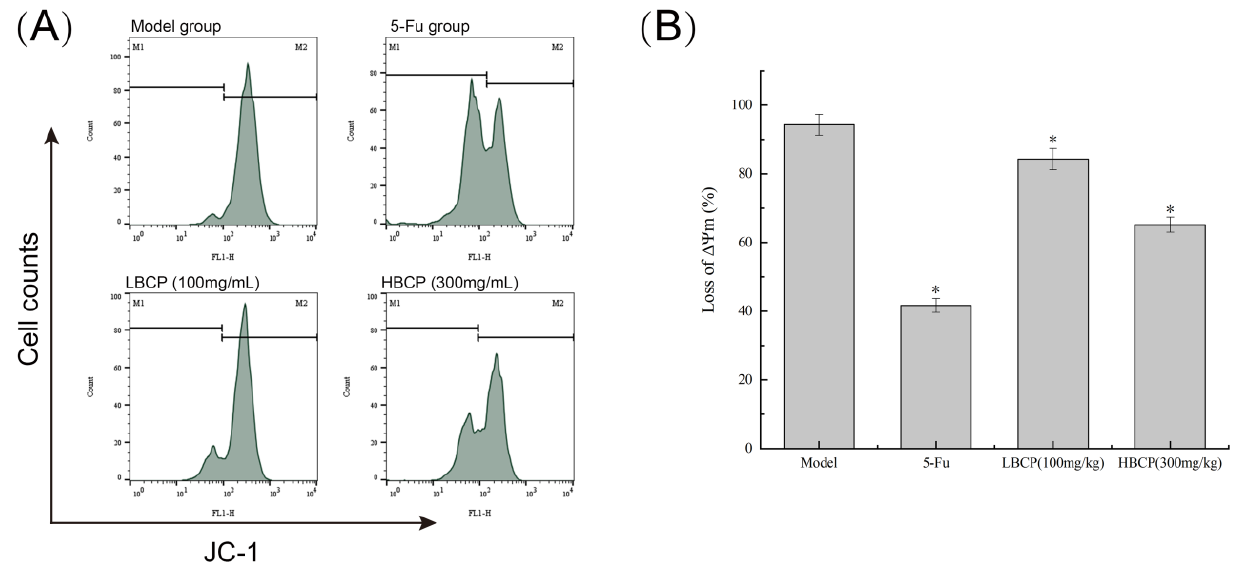
Figure 14. ( A ) MMP disruption in H22 solid tumor cells by JC-1 staining in different groups; ( B ) Bar graph of the mitochondrial membrane potential changes in H22 cells. * p < 0.05 indicated significant compared to model